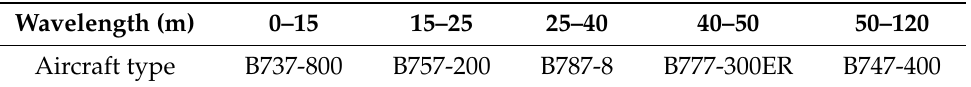
Table 9. Selection of simulation aircraft under different wavelength